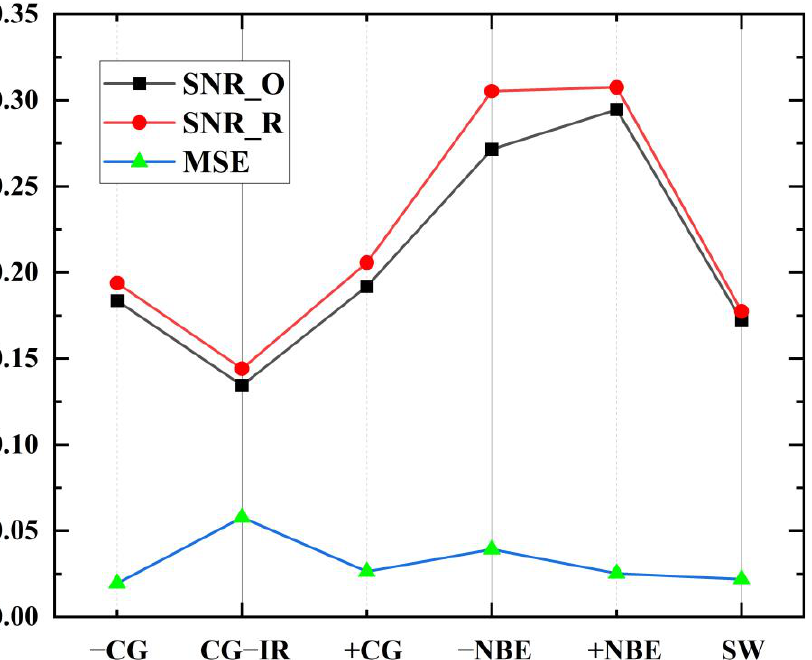
Figure 11. MSE comparison chart of LEMP waveforms after LCSAE model training.